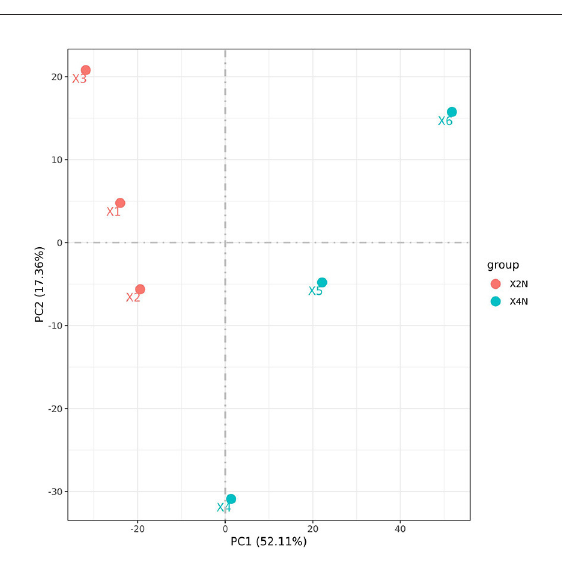
FIGURE3 Principle component analysis (PCA) of diploids